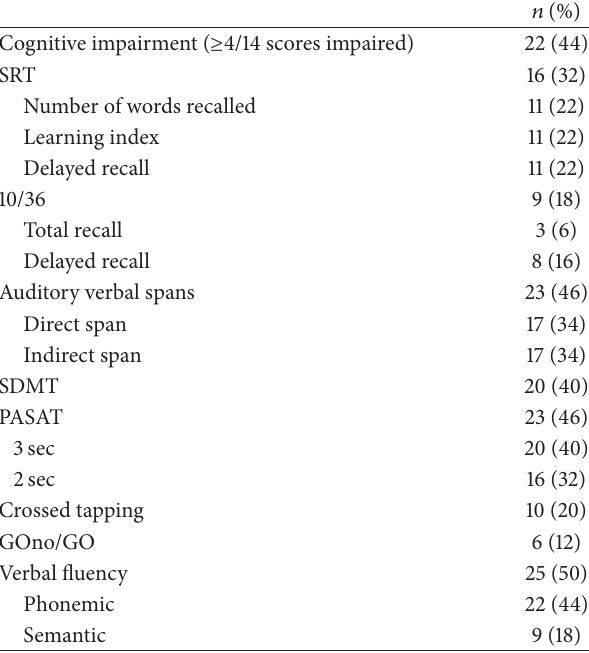
Table 3: Proportion of MS patients with impaired cognitive dys- function, assessed using